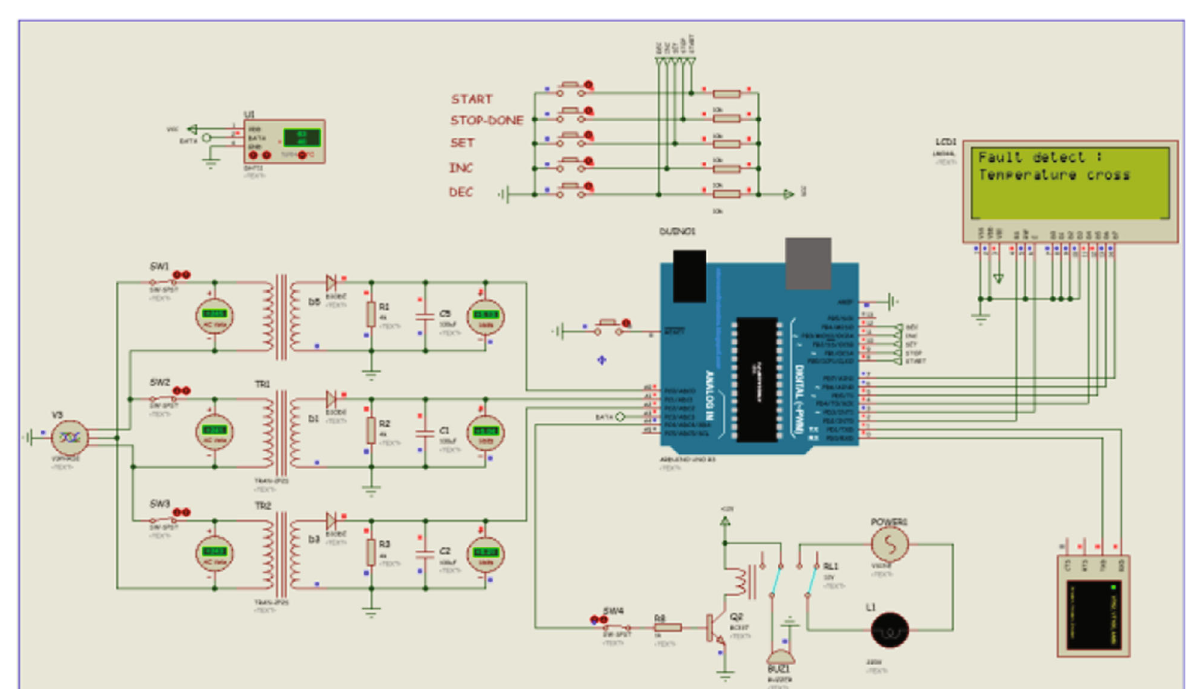
Figure 5: Overtemperature condition.